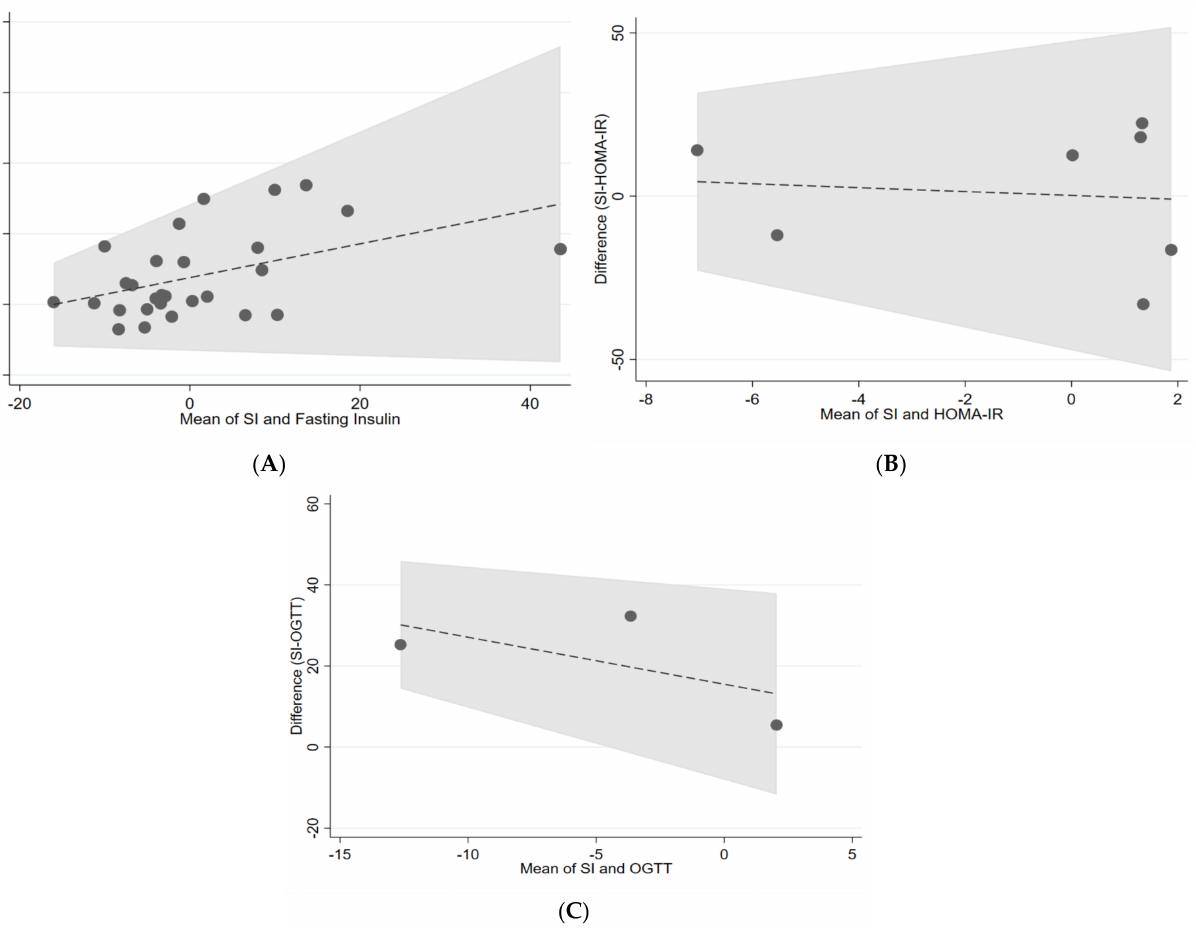
Figure 4. Bland–Altman plots of ( A ) SI vs. fasting insulin, ( B ) SI vs. HOMA-IR, ( C ) SI vs. OGTT. The central dashed line represents the mean difference between measures represented as log values. The area in grey represents the 95% confidence intervals. HOMA-IR = homeostatic model assessment for insulin resistance, OGTT = oral glucose tolerance